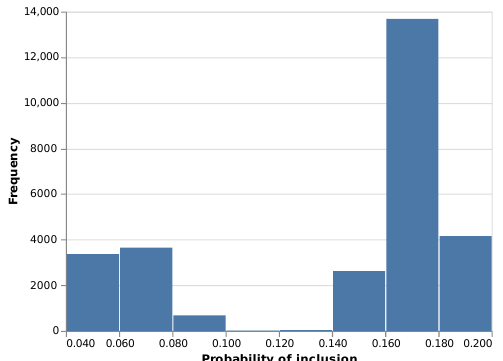
Figure 2. Histogram of population propensities in SC2.